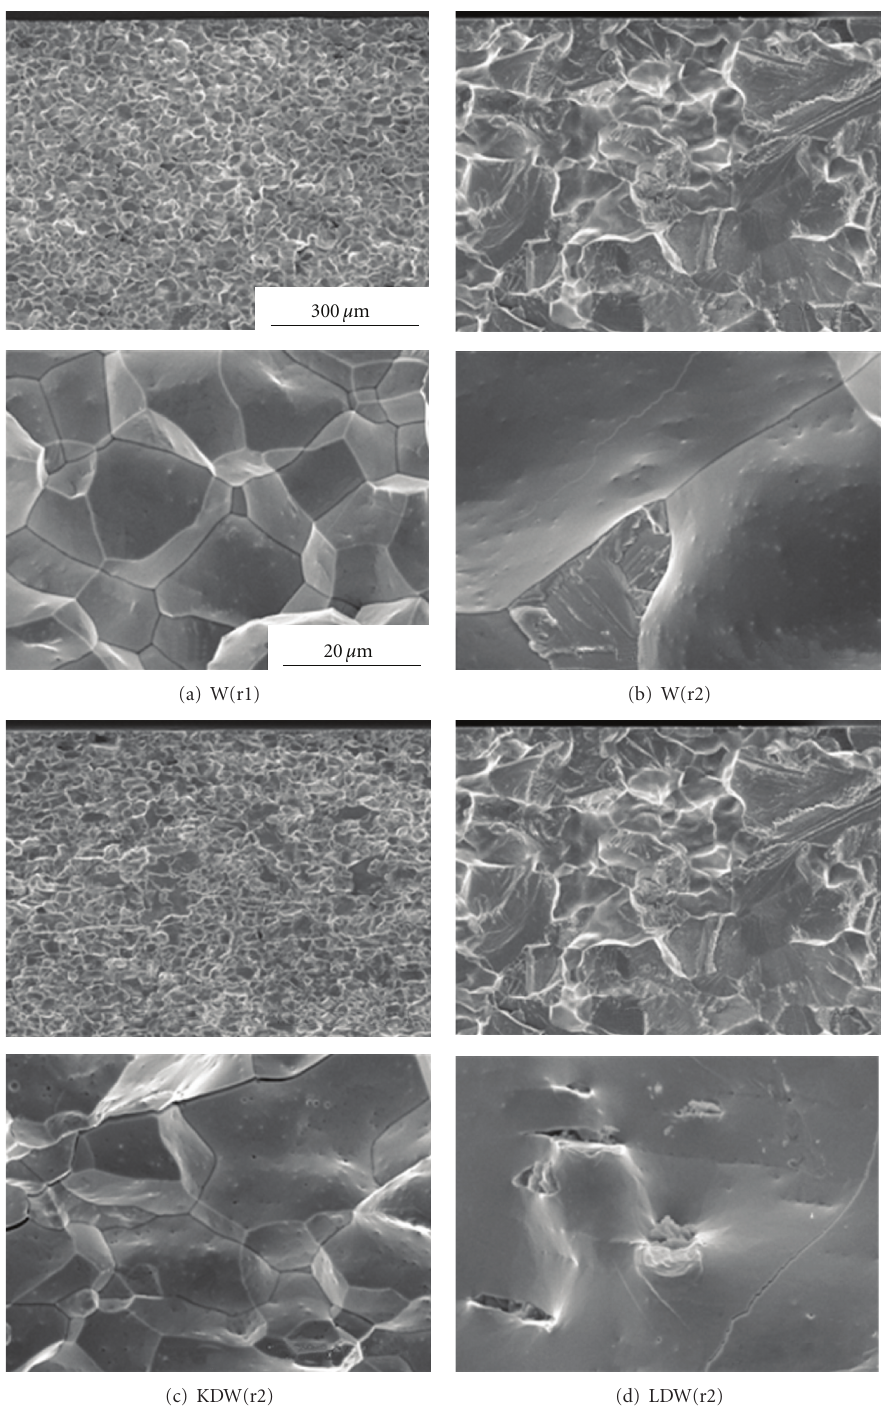
Figure 5: Typical fracture surfaces of various